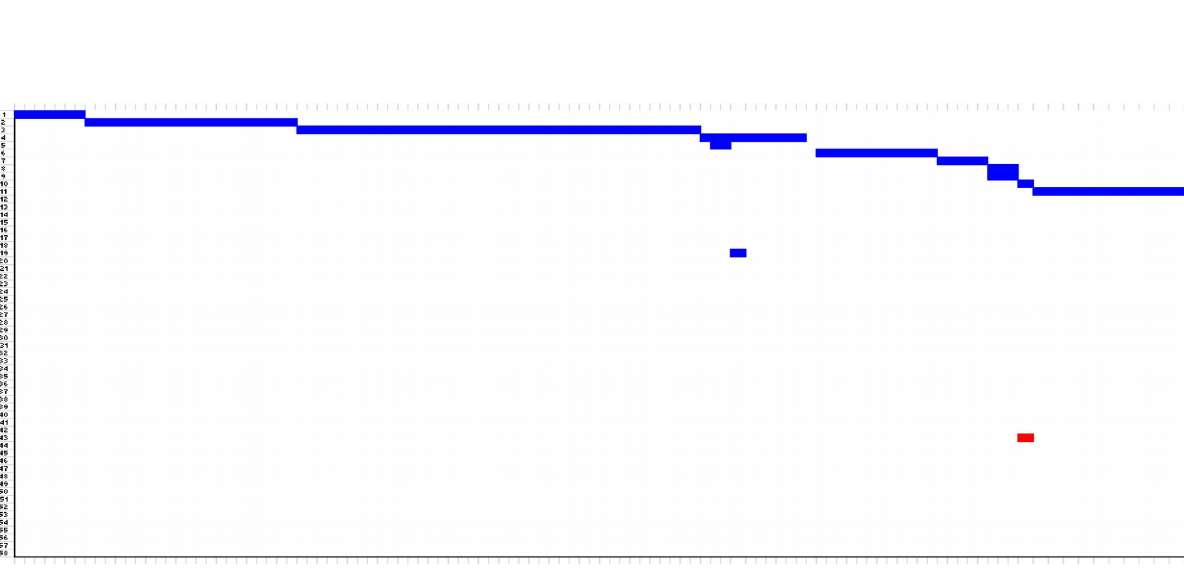
Figure 64. The modified Gantt chart for the Hospital